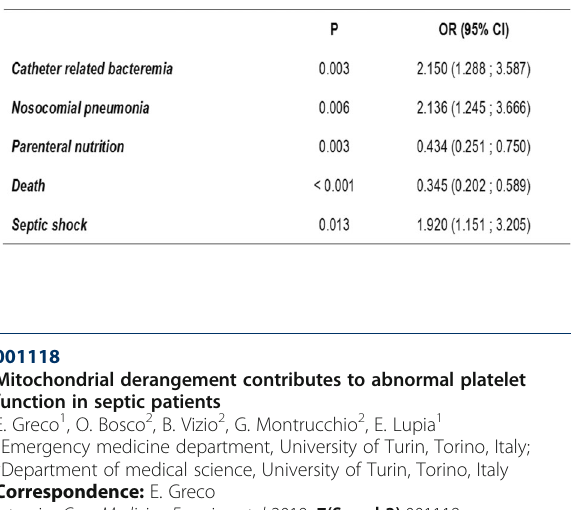
Table 2 (abstract 001068). Multivariante logistic regression for the De-